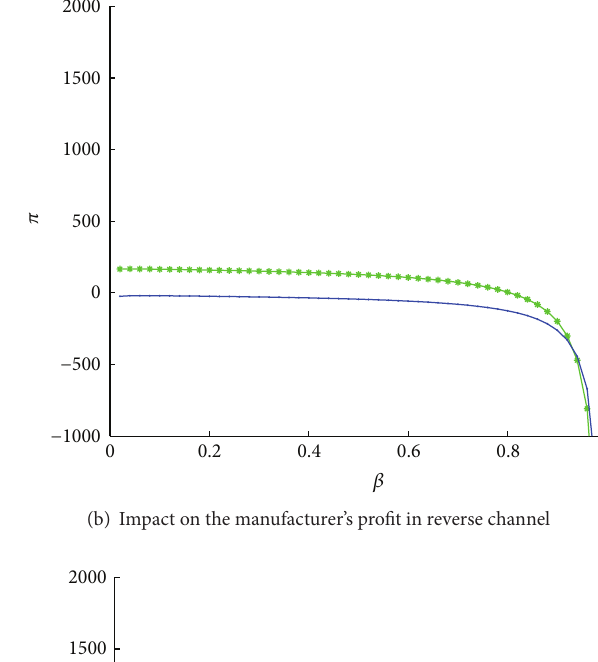
optimal prices and optimal channel profits and